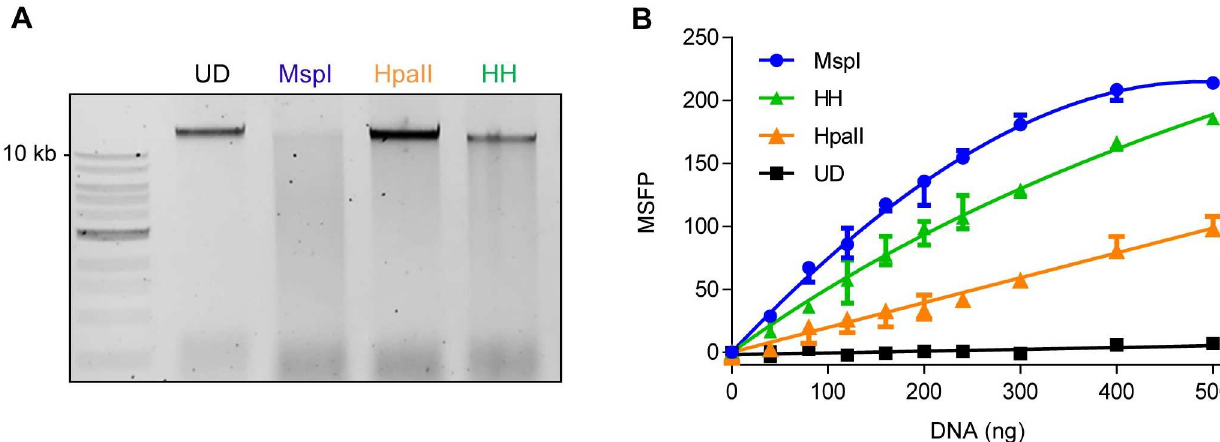
Fig 3. Application of the MSFP assay to human genomic DNA. (A) Digestion pattern of THP-1 genomic DNA digested with MspI, HpaII, or a combination of HpaII and HpyCH4IV (HH). The digested DNA was separated by agarosegel electrophoresis. UD; undigested.(B) Standard curves for THP-1 DNA in the MSFP assay. Data represent medians and ranges of three independent experiments performed in technical duplicatesor triplicates. The amounts of digested DNA appliedper well are indicatedon the x-axis.